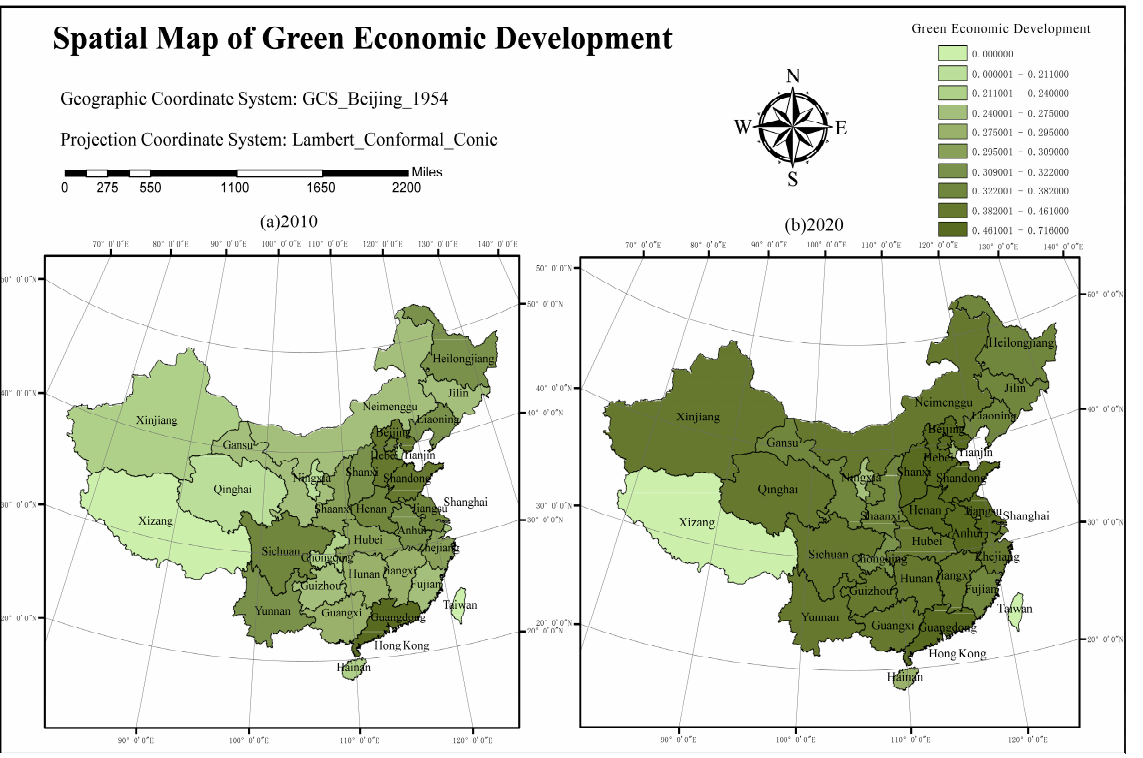
Figure 1. Spatiotemporal differentiation diagram of a green economy. Note: The islands in the South China Sea are not shown in the figure.